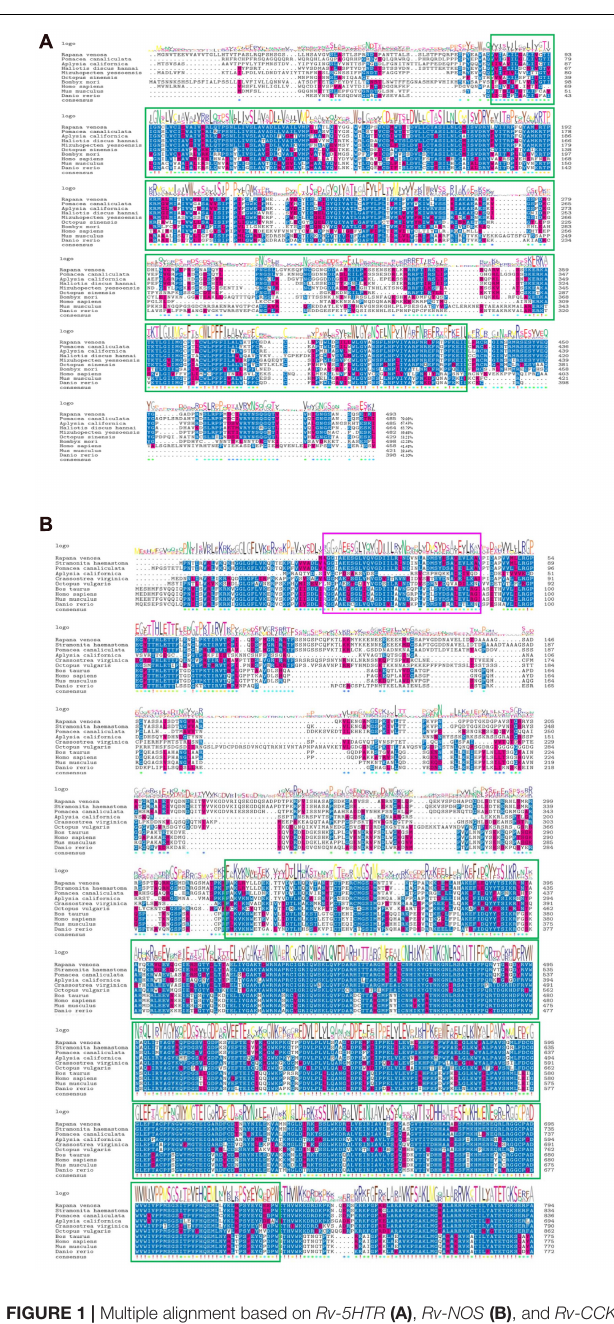
FIGURE 1 | Multiple alignment based on Rv-5HTR (A) , Rv-NOS (B) , and Rv-CCKR (C) deduced amino acid sequences from Rapana venosa and other species. Rv-5HTR : serotonin receptor subtype domain 7, denoted in green box; Rv-NOS : PDZ domain denoted in pink box, NOS eukaryotic oxygenase domain denoted in green box and ferredoxin-reductase (FNR) like C-terminal domain denoted in yellow box; Rv-CCKR : CCK receptors domain denoted in green box. Additionally, the logo shows how conservative motif is in each position. The higher the letter, the more conservative the position. Different amino acids in the same position will scale according to its frequency. ( 5-HT receptor : GenBank Accession No. MW383250; NOS : GenBank Accession No. MW383249; CCK receptor : GenBank Accession No. MW383248) (The proteins used in the analysis were showed in Supplementary Table 2